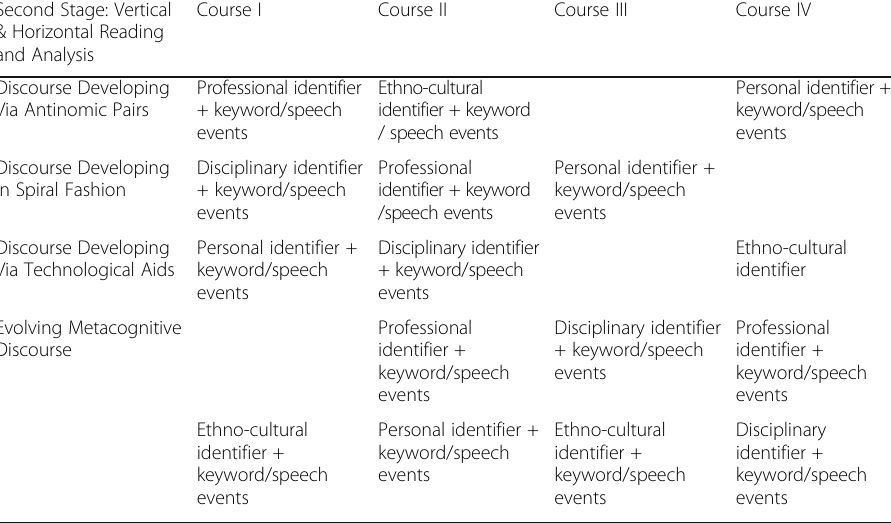
Table 2 Second stage: vertical & horizontal reading and analysis Second Stage: Vertical & Horizontal Reading and